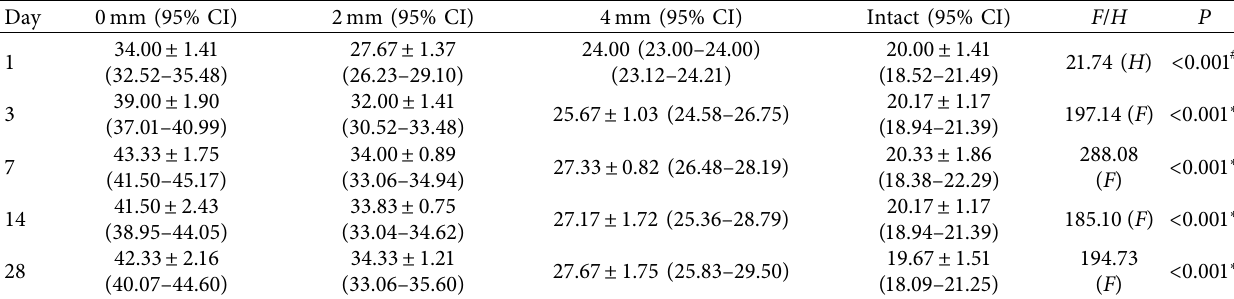
Table 5: Changes in mean number of astrocytes (/mm 2 ) in the C7 neurotomy subgroups.